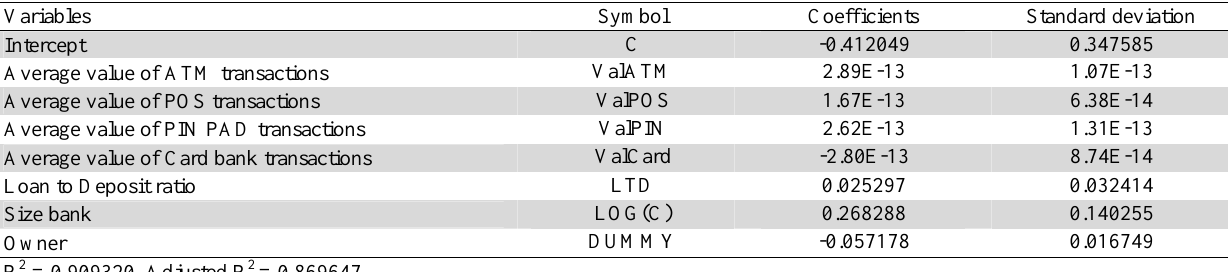
The relationship between the development of e-banking and LQTDF